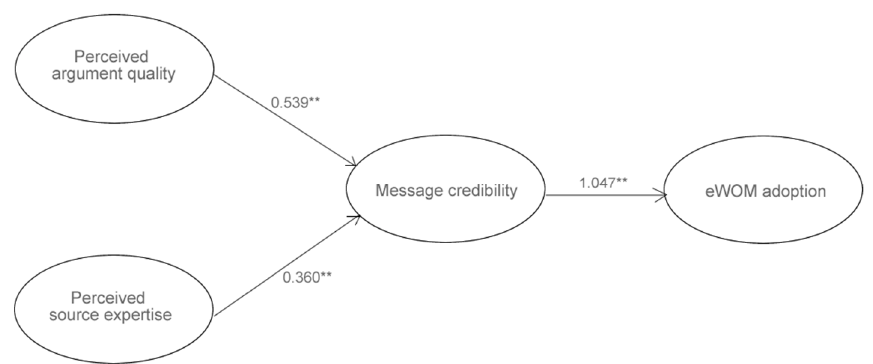
Figure 1. The causal model.